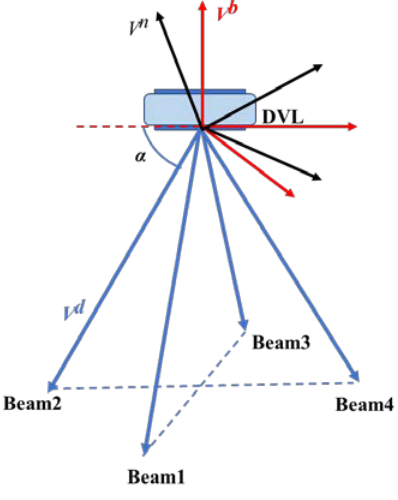
Figure 3. Relationships between different frames.